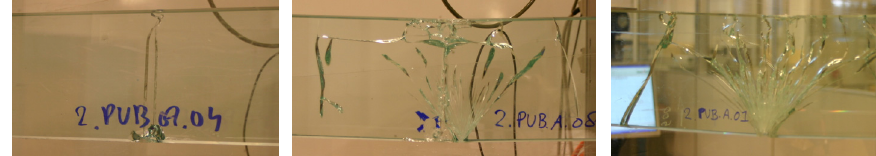
Figure 2a, b, c: Fracture pattern at initial failure in a double layer annealed glass beam tested in 4-point bending after respectively: both glass layers broken by predamage (full damage), 1 layer broken by predamage (partial damage), no predamage.